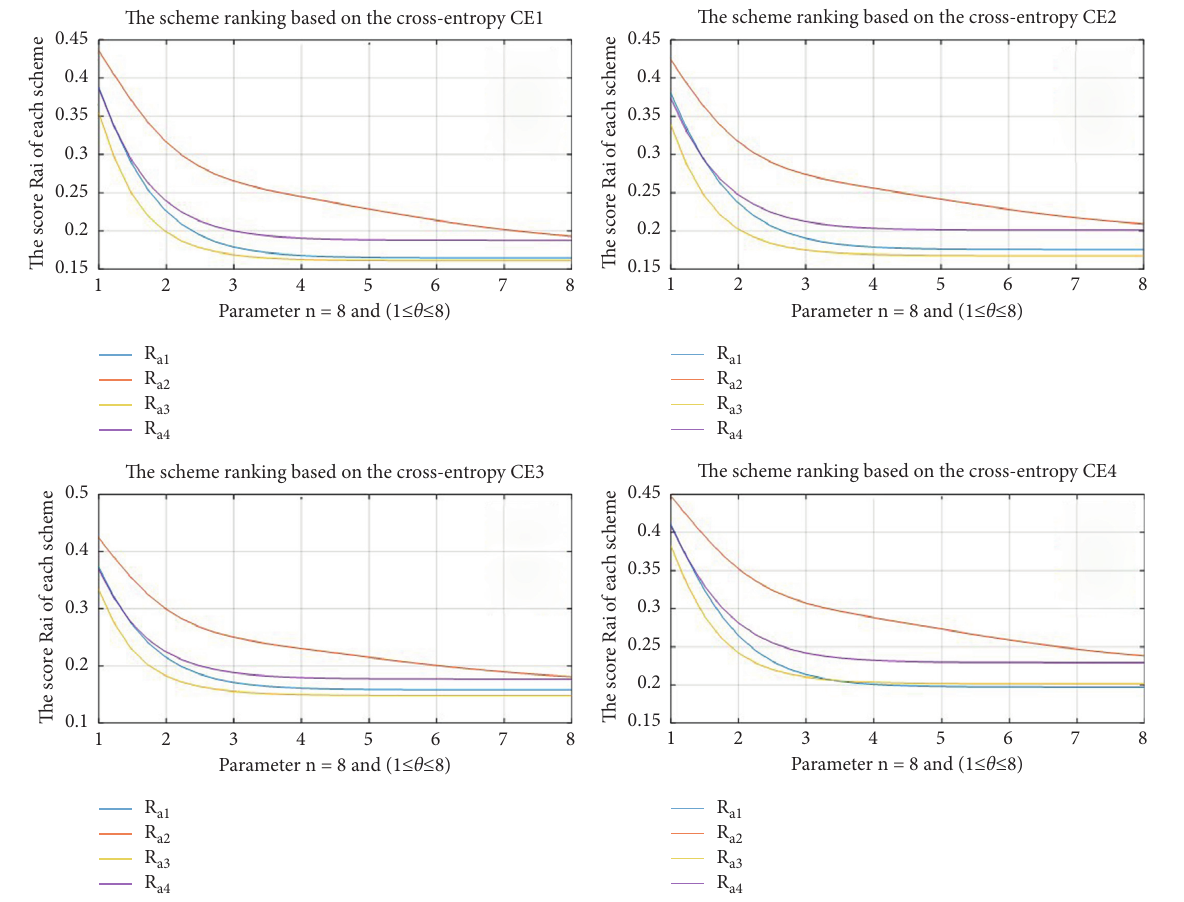
Figure 13: Ranking score of each alternative based on parameters n � 8, 1 ≤ θ ≤